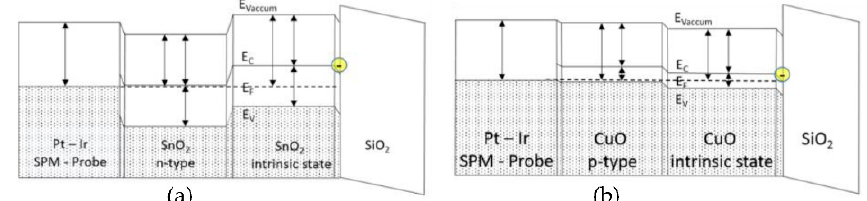
Figure 4. Band structure of the SPM-probe placed on ( a ) SnO 2 NW and ( b ) CuO NW on SiO 2 substrate, with E C the conduction band, E V the valence band, and E F the Fermi